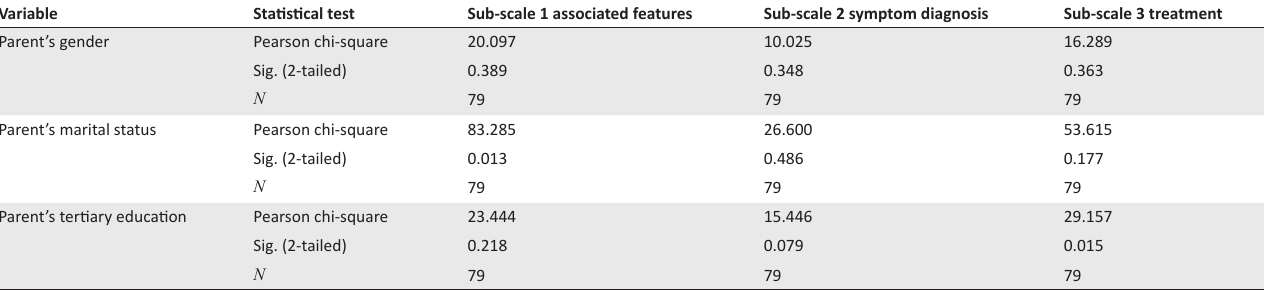
TABLE 5: Association of Knowledge of Attention Deficit Disorder Scale sub-scale score (knowledge) with parental factors.